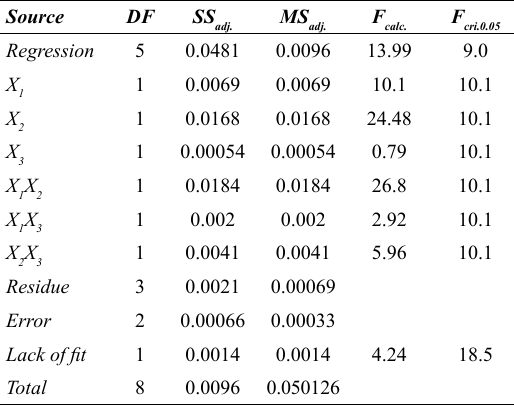
Table 6. ANOVA calculations for the pores volume data.